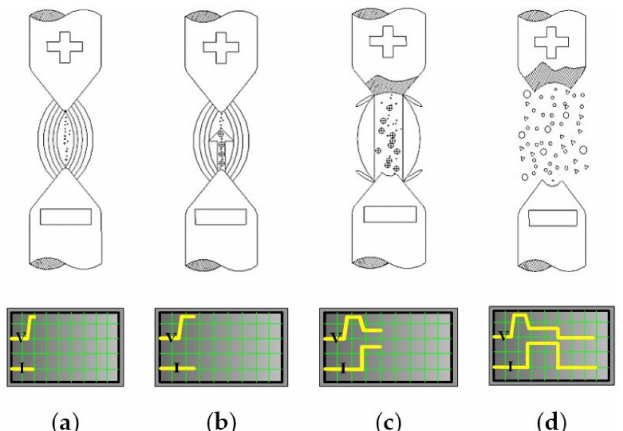
Figure 1. Steps involved in nanoparticle formation through micro-electric discharge machine (ESDM). ( a ) Molecular polarization and formation of a low-resistance channel. ( b ) Ionization and emission of electrons from the cathode. ( c ) Metal melt and vaporization. ( d ) Suspension of particles.